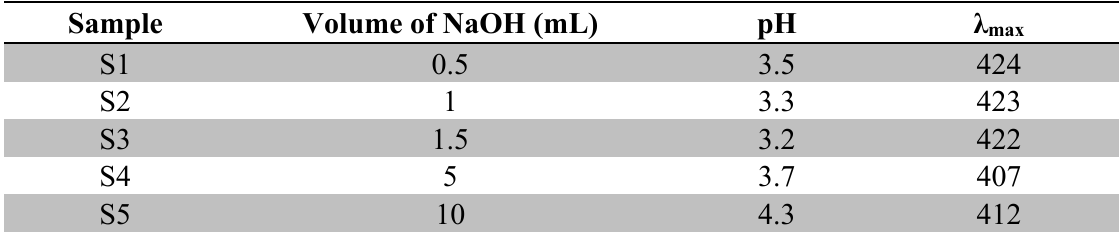
Table 1. The characteristics of Ag-NPs prepared at different volumes of NaOH.